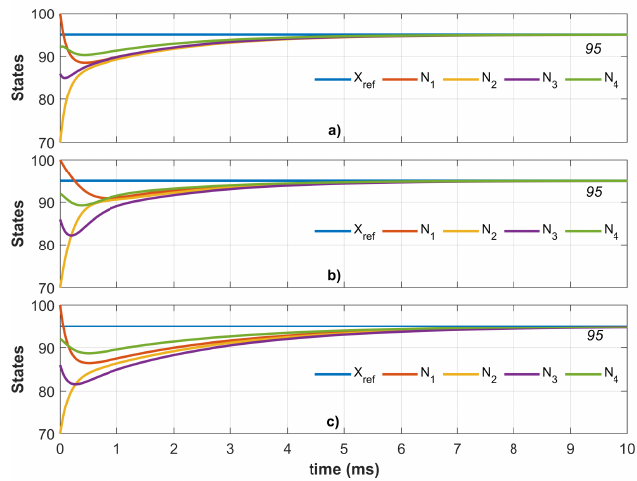
Figure 10. Convergence of the system for the different graph topologies applying the leader-following consensus protocol in discrete-time; ( a ) undirected graph; ( b ) directed and balanced graph; ( c ) directed and